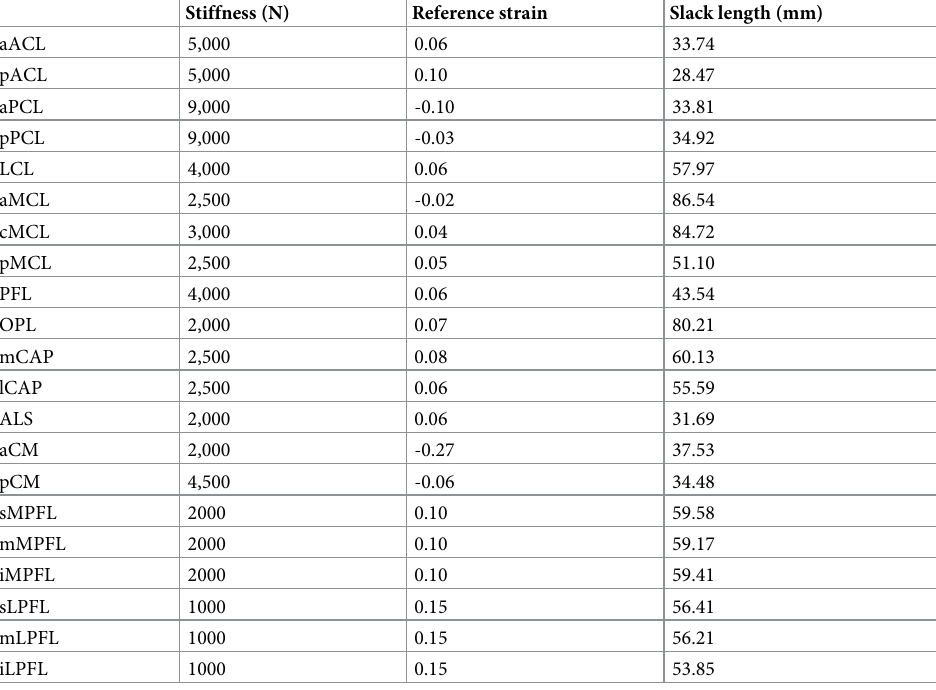
Table 1. Material properties in the ligaments used in this